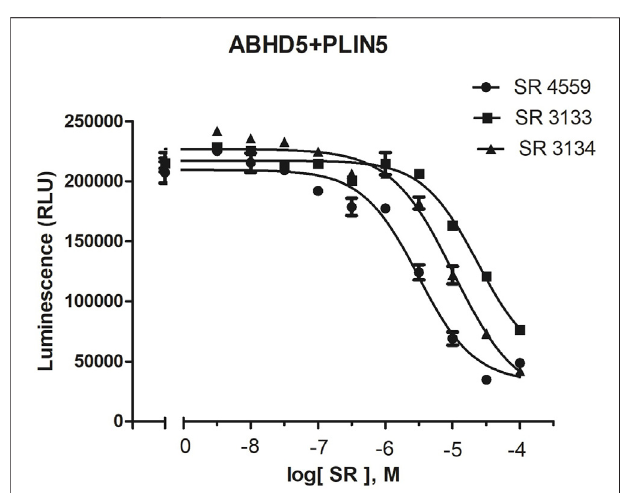
FIGURE 6 | The binding of SPZ ligands to ABHD5 was assessed by dose-response curves of ABHD5-PLIN5 binding. ABHD5-PLIN5 binding was assessed by luciferase complementation assays of Cos7 lysates. Each ligand has micromolar IC 50 values with speci fi c binding to ABHD5 (Sanders et al.,